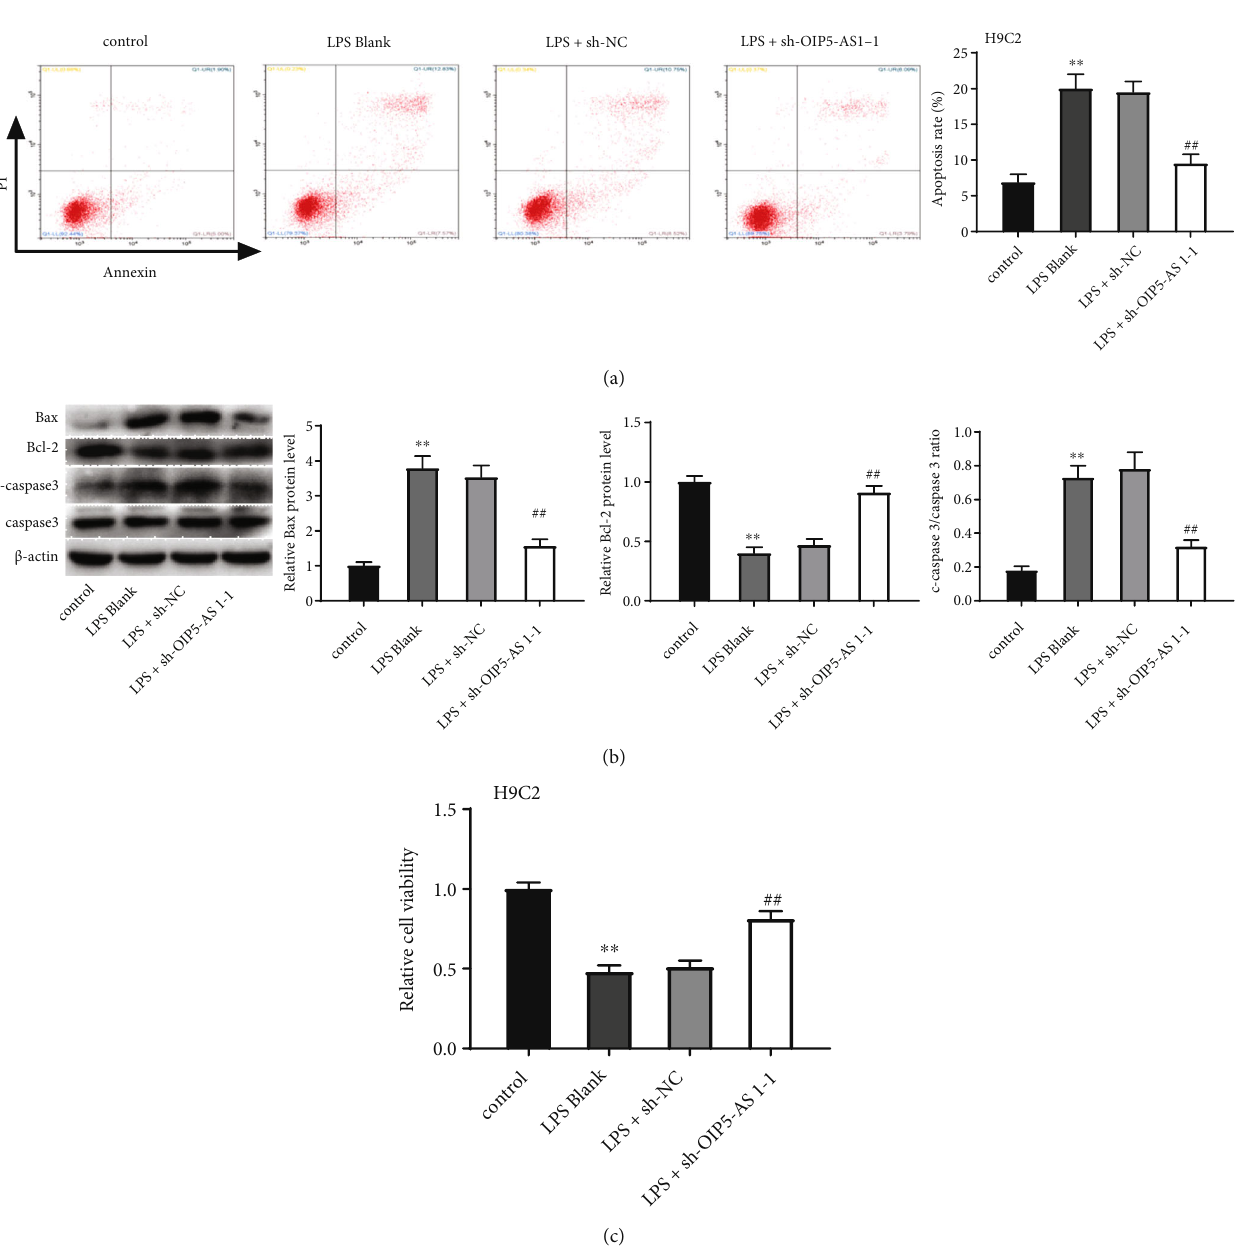
Figure 4: Knockdown of OIP5-AS1 inhibits the apoptosis and promotes the proliferation of LPS-induced H9C2 cells. (a) The apoptosis rate of LPS-induced H9C2 cells was determined by fl ow cytometry. (b) The protein expression of Bax, Bcl-2, caspase3, and c-caspase3 in LPS- treated H9C2 cells was detected by western blot. (c) The viability of H9C2 cells was determined by MTT assay. ** P < 0 : 01 versus control. ## P < 0 : 01 versus LPS